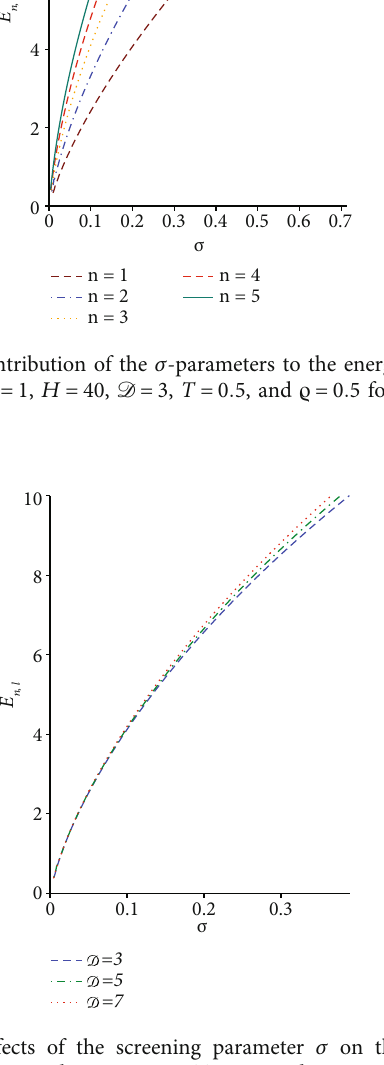
Figure 8: E ff ects of the screening parameter σ on the energy spectra with μ = c = ℏ = 1 , Η = 40 , T = 0 : 5 , and ϱ = 0 : 5 for D = 3 , 5, and 7.